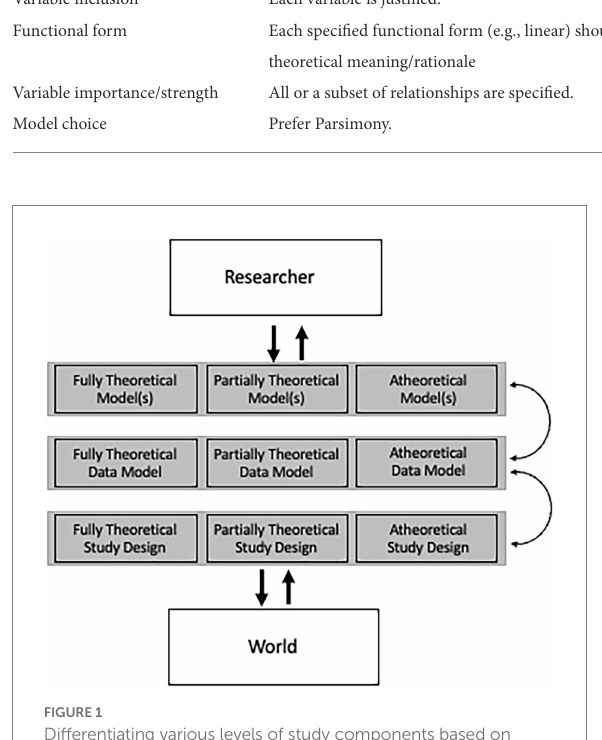
FIGURE 1 Differentiating various levels of study components based on Suppes (1966) and Kellen (2019).